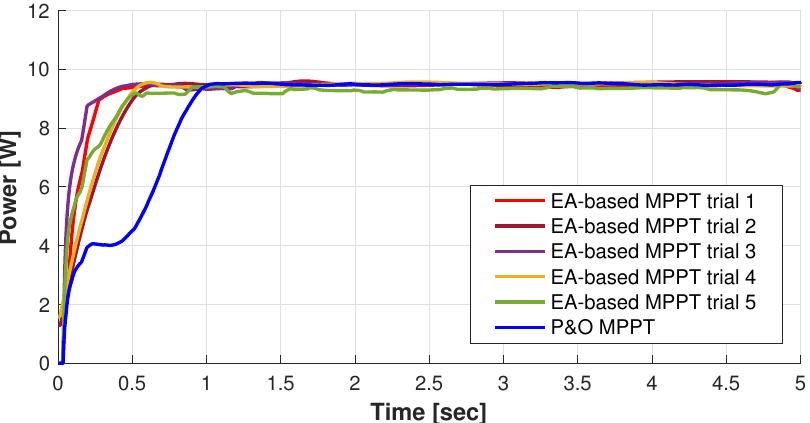
Figure 35. Averaged experimental performance of the MPPT algorithms, comparing different test trials of the proposed EA-based MPPT and P&O algorithm.